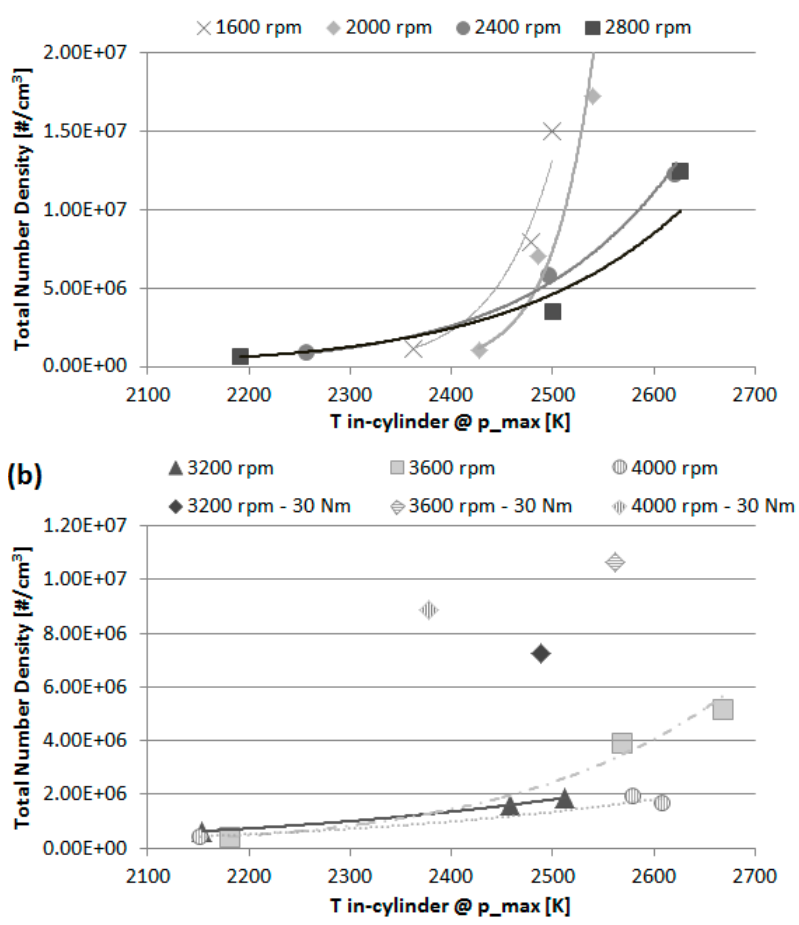
Figure 7. Total particle number density plotted as a function of modelled in-cylinder gas temperature at the location of maximum pressure. For ease of visualisation, the data are grouped by fixed engine speed and split into two plots. ( a ) Refers to engine speeds between 1600 and 2800 rpm; ( b ) refers to engine speeds between 3200 and 4000 rpm. Some outliers have been removed.